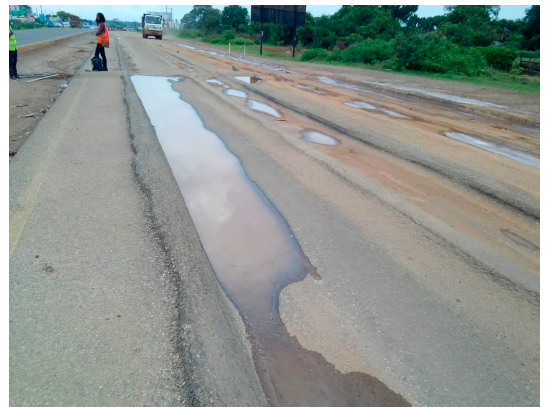
Figure 9. Extent of rutting (Kitwe-Chingola).